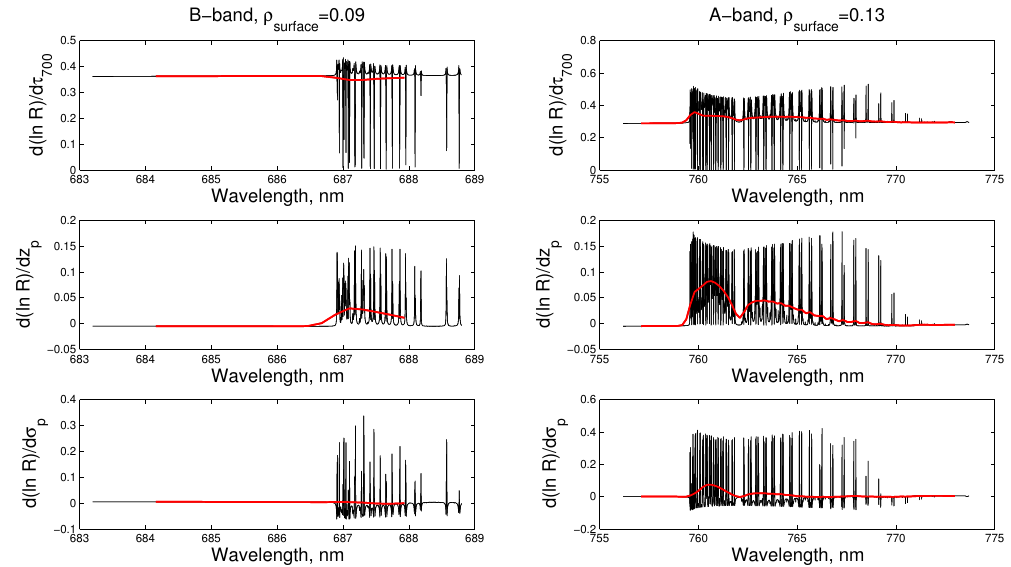
Fig. 3. Same as Fig. 1, but for a dark, medium contrast surface with ρ B =0.09 and ρ A =0.13. Note, however that the respective scales may